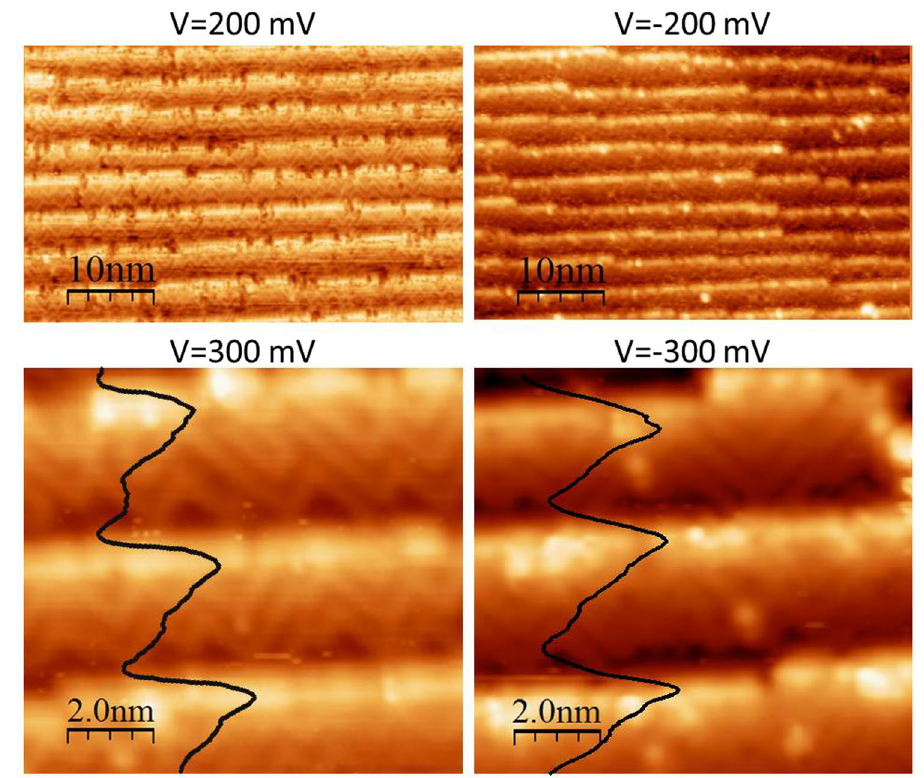
Figure 2. STM images over a large spatial range (top panels) and zoom outs representative of the prepared surface (bottom panels). The left panels were measured with V = 200 mV and V = 300 mV thus sampling the unoccupied states whereas the right panels were measured with V = − 200 mV and V = − 300 mV and sample the occupied states. Large brightness contrast can be observed at the terraces and high intensity at the step- edges. From the zoom out we can conclude the presence of chains in both empty and occupied electronic states. The black lines are intensity profiles showing maximum brightness at the step